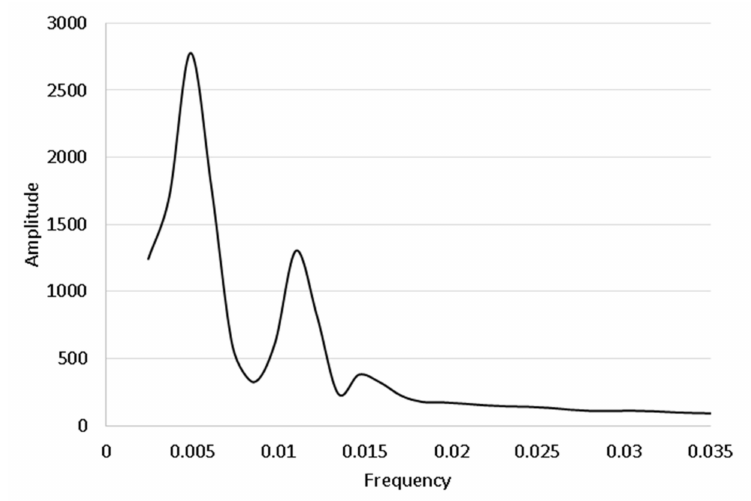
Figure 9. Result of FFT analysis of mass